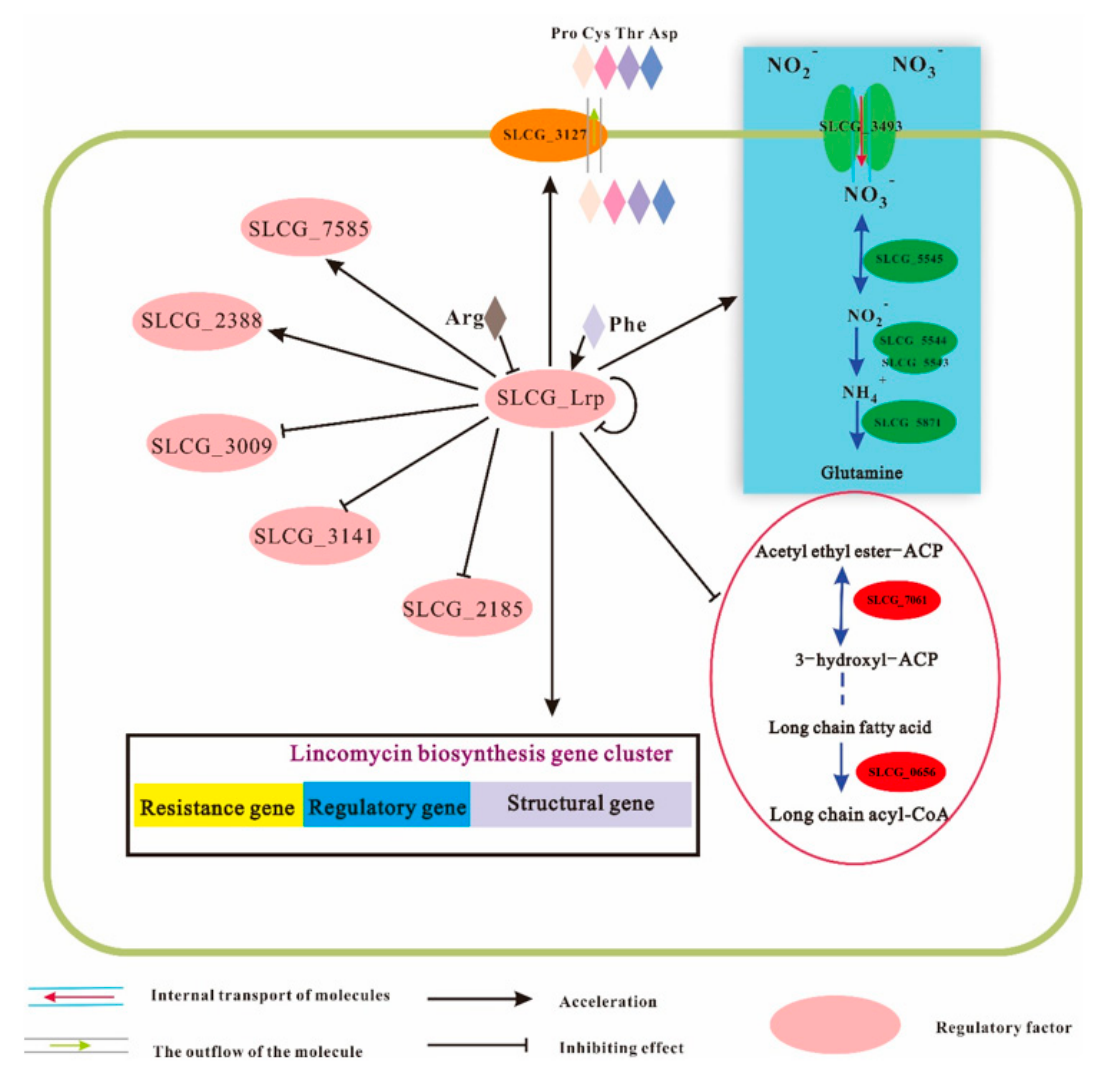
Figure 9. SLCG Lrp − mediated regulatory landscape in S. lincolnensis